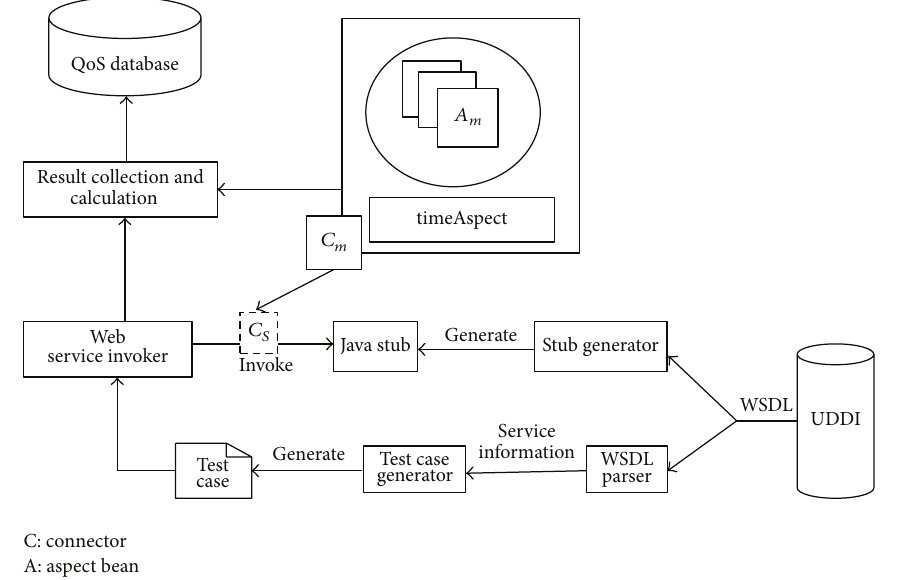
Figure 2: The architecture of the WS-QoS measurement